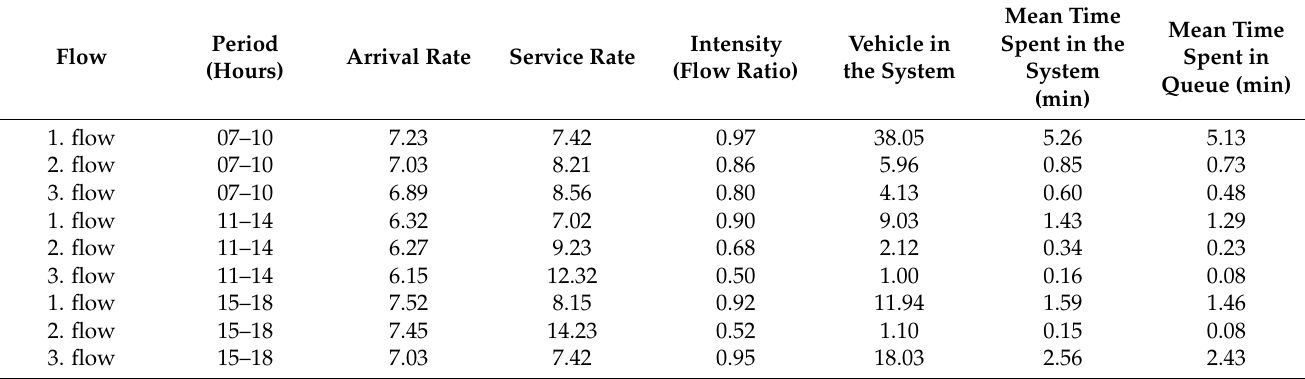
Table 10. The 1 day performance values at Kartal Sahilyolu Junction.